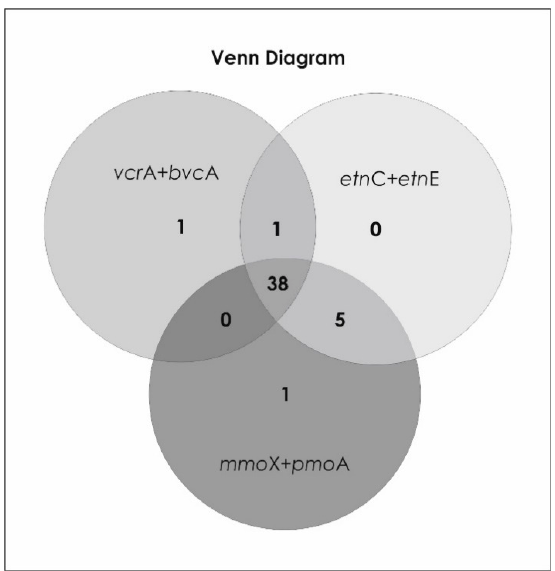
Figure 2. Venn diagram showing the numbers of groundwater samples where functional gene groups were found individually or jointly (value of Cq = 40 was used as the detection limit, see Section 2.3 for more information).